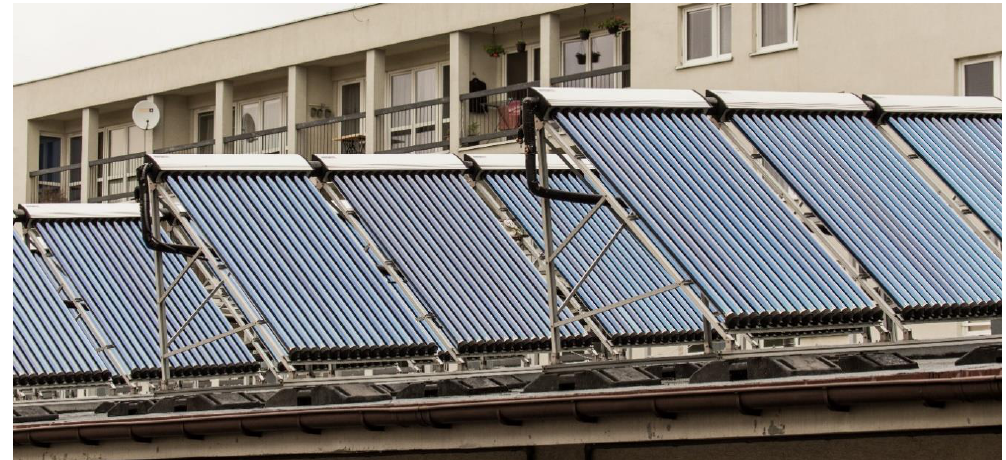
Figure 3. The ETC installation in Krosno.